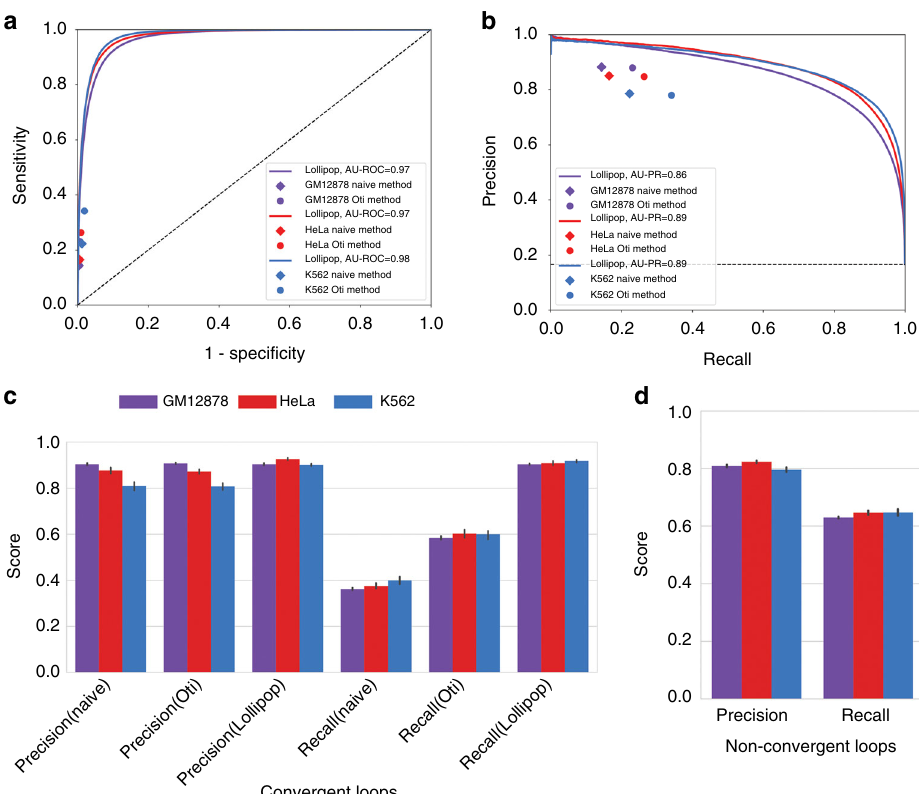
Fig. 3 Performance evaluation within individual cell types. a , b Performance evaluation using a receiver operating characteristic (ROC) and b precision – recall (PR) curve. Performance of the naïve and Oti methods are represented by diamonds and circles, respectively. Results in GM12878, HeLa, and K562 are shown in purple, red, and light blue, respectively. c Comparison of the precision and the recall of the three methods in predicting convergent loops. d Evaluation of Lollipop ’ s performance on non-convergent loops, which include tandem loops, divergent loops, and loops without CTCF motifs in the anchors. The bars in c and d denote 95% con fi dence intervals from 10-fold